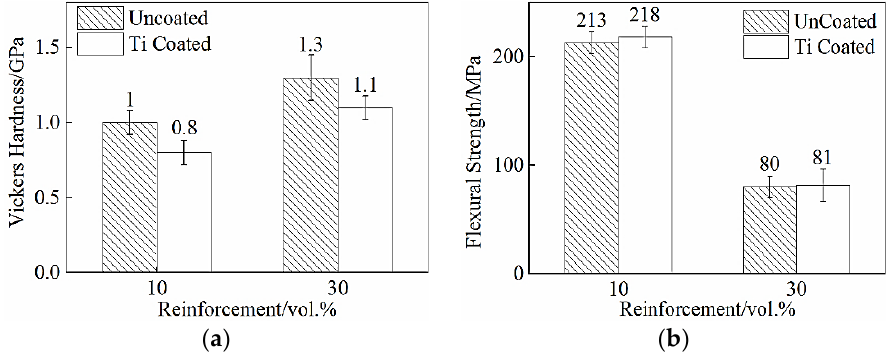
Figure 12. The mechanical properties of Ti 3 AlC 2 /Cu composites before and after coating: ( a ) Micro-Vickers hardness of different content; ( b ) Flexural strength of different content.